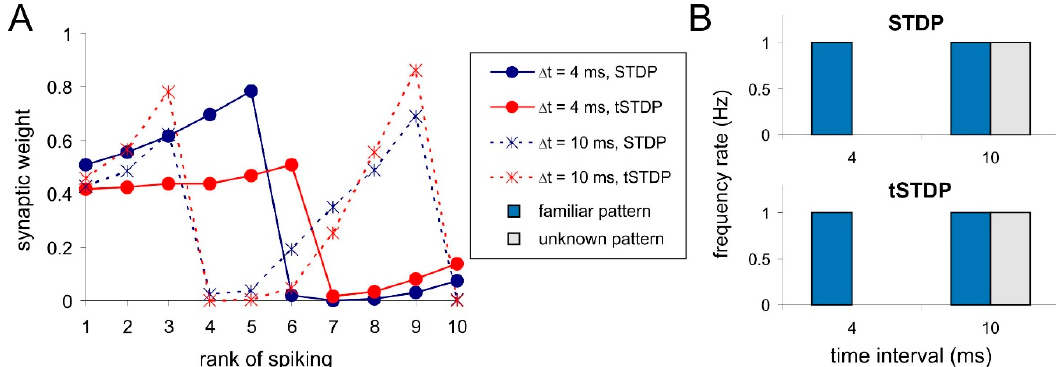
Figure 3. Temporal coding results of simulations with different inter-spike intervals using pair-based rule (spike timing-dependent plasticity, STDP) and triplet-based rule (tSTDP): ( A ) Synaptic weights vs. the rank of spiking on corresponding synapses; ( B ) The response of the postsynaptic neuron to familiar and unknown pattern.